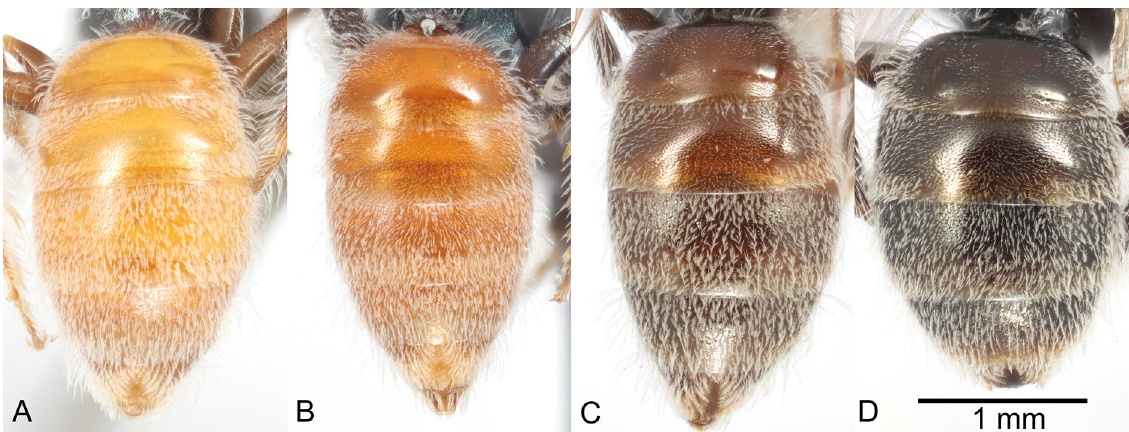
Fig. 1. Colour variation in the metasoma of Lasioglossum ( D. ) hudsoniellum (Cockerell, 1919). A . Yellow-orange. B . Red-orange. C . Reddish brown. D . Black. “Red-tailed” Lasioglossum ( Dialictus ) are considered to be any species with natural colour matching A or